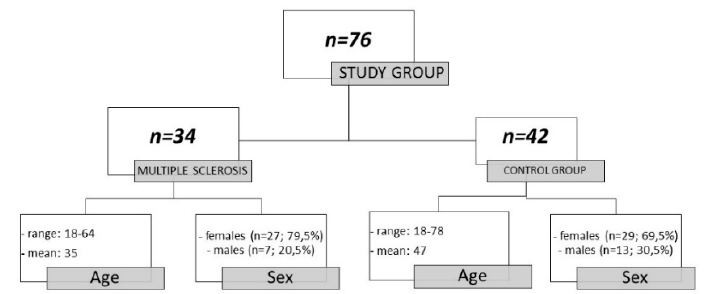
Figure 1. Characteristics of the study group.